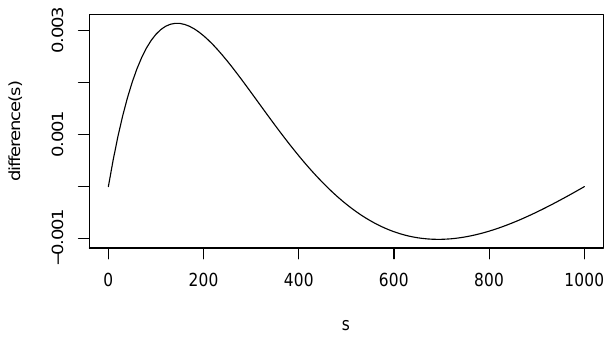
Figure 2: Plot of the difference P [ X 1 − T > s | X 1 > T , X 2 > T ]− P [ X 2 − T > s | X 2 > T , X 2 > T ] for T = 1000 when the vector ( X 1 , X 2 ) has exponentially distributed margins, with E [ X i ] = 1000 , and survival copula defined as in (2.6), with ρ = 1, β 1 = α 1 = 2 and β 2 = α 2 = 1